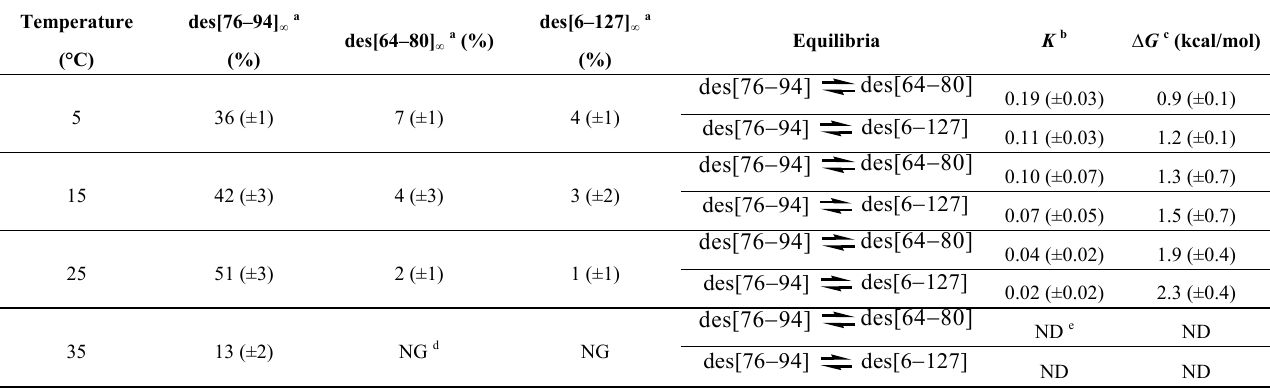
Table 1. Thermodynamic parameters for the equilibria between the three des intermediates of HEL at pH 8.0 in the presence of 2 M urea.